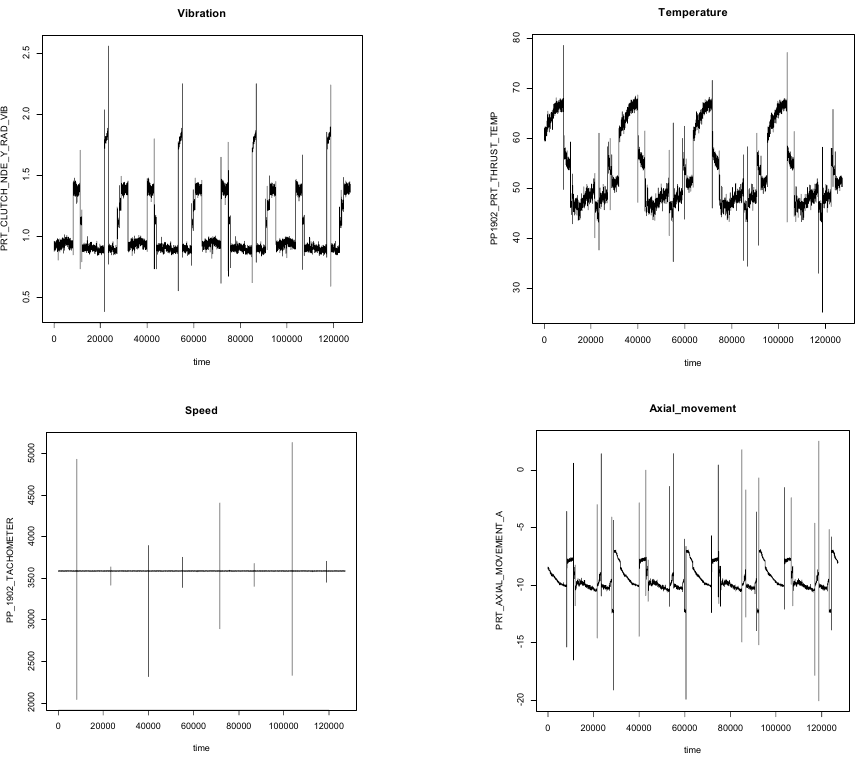
Figure 6. Visualization of gathered sensor data.